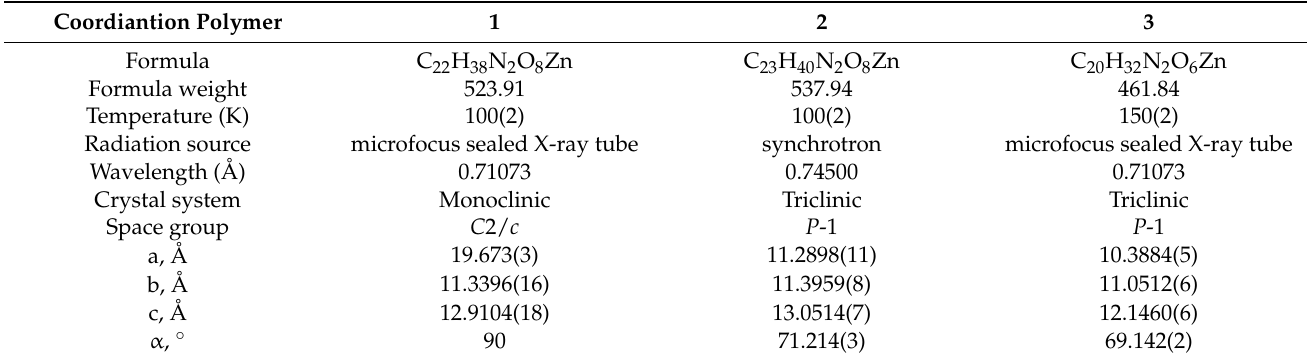
Table 1. Structure refinement details and crystal data for 1 – 3